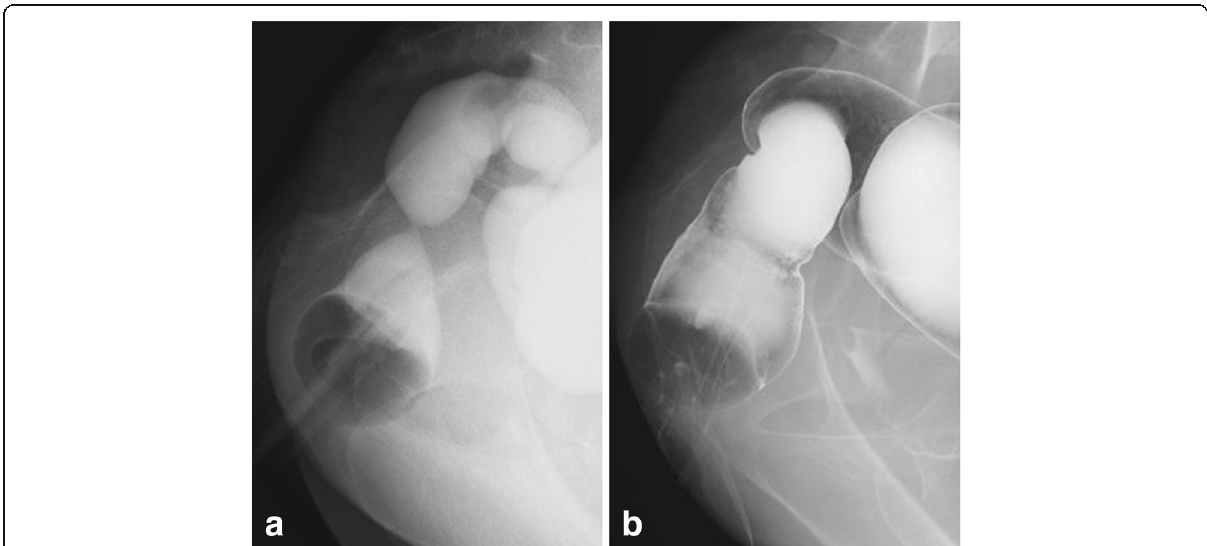
Fig. 4 Postoperative lower gastrointestinal (GI) series. Lower GI series by gastrografin at 7 months after laparotomy demonstrated rectal stenotic lesions ( a ). However, successful evacuation of the contrast media was confirmed despite the present stenosis. The stenotic lesion was resolved and defecation has been maintained after stoma closure ( b